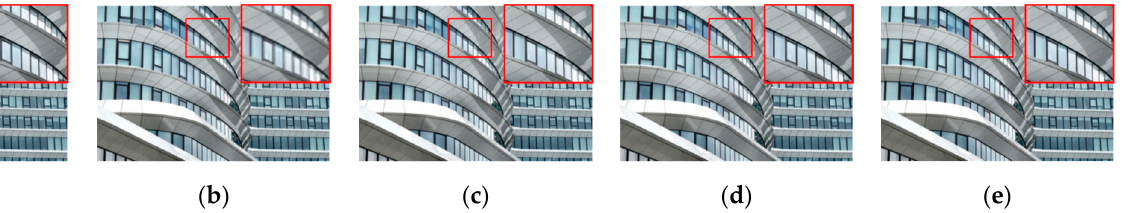
Figure 15. Visual evaluation for a scale factor of 4× on the image “img052” from Urban100: ( a ) Ground Truth (PSNR, SSIM); ( b ) Bicubic (28.24, 0.7311); ( c ) VDSR (32.57, 0.8875); ( d ) EDSR (35.11, 0.9319); ( e ) Proposed (35.13, 0.9322) .